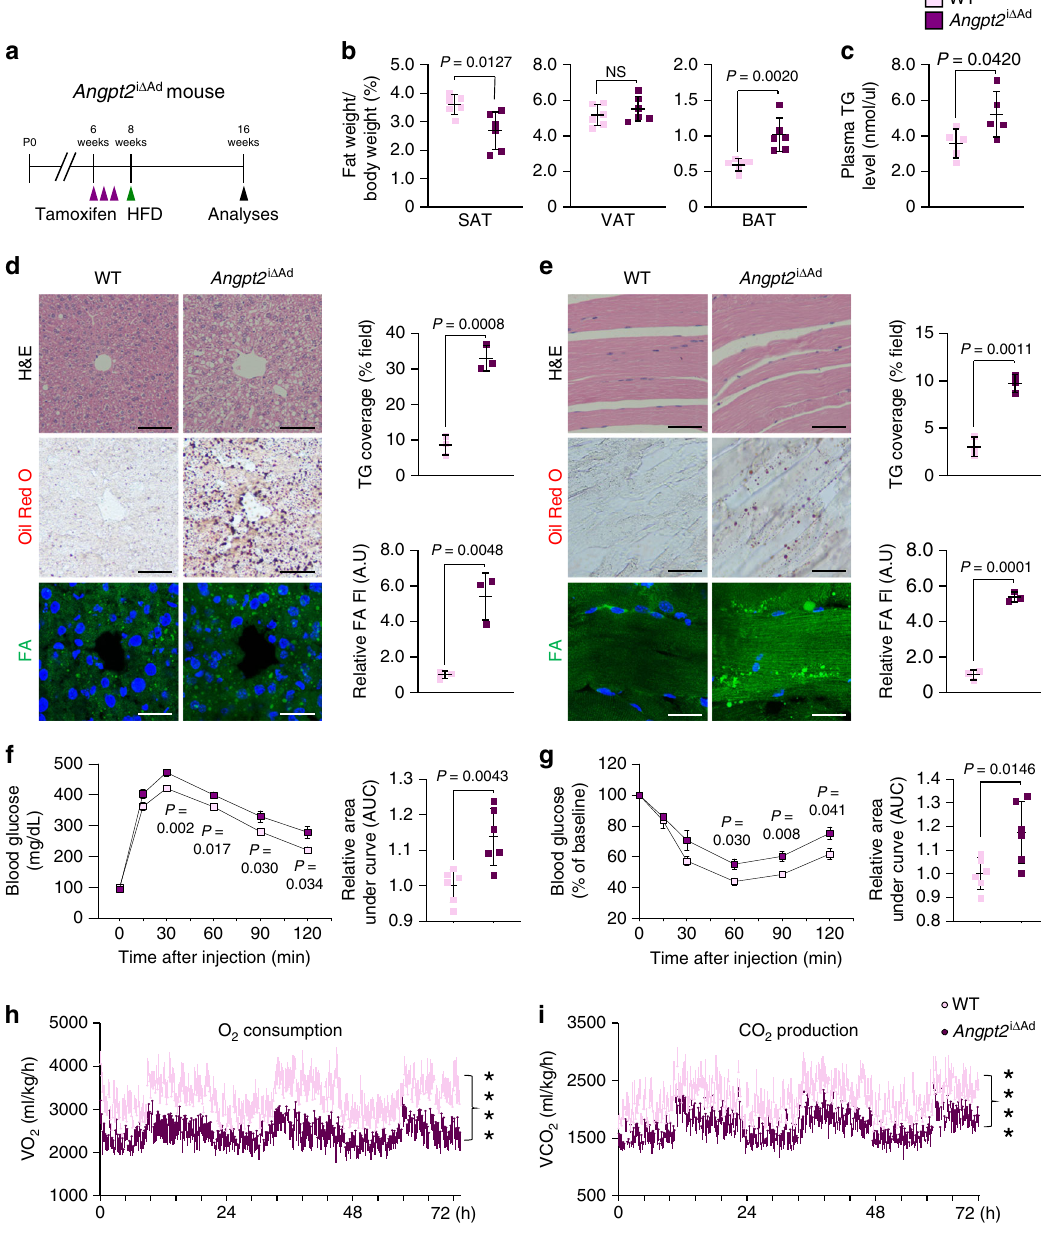
Fig. 9 Adipocyte-derived Angpt2 prevents ectopic lipid-induced insulin resistance. a Generation of Angpt2 i Δ Ad mouse, inducible and speci fi c deletion of Angpt2 in adipocytes in 6-week-old mice, and analysis after 8 weeks of HFD. Purple arrowheads indicate daily injections of tamoxifen. b Comparisons of fat-to-body weight ratio in different adipose tissues between WT and Angpt2 i Δ Ad mice fed with HFD. Each dot indicates a value obtained from one mouse and n = 6 mice/group pooled from two independent experiments. c Comparison of plasma triglyceride (TG) levels between WT and Angpt2 i Δ Ad mice. Each dot indicates a value obtained from one mouse and n = 5 mice/group pooled from two independent experiments. d Representative images and comparisons of H&E-stained sections, Oil Red O staining and coverage (% of fi eld), and BODIPY-FA staining and uptake ( fl uorescent unit, FI) of liver between WT and Angpt2 i Δ Ad mice fed with HFD. Each dot indicates a mean of triplicate values from three independent experiments. Scale bars, 50 μ m. e Representative images and comparisons of H&E-stained sections, Oil Red O staining and coverage (% of fi eld), and BODIPY-FA staining and uptake (FI) of skeletal muscle between WT and Angpt2 i Δ Ad mice fed with HFD. Each dot indicates a mean of triplicate values from three independent experiments. Scale bars, 50 μ m. f , g Comparisons of intraperitoneal glucose tolerance test (IPGTT) and intraperitoneal insulin tolerance test (IPITT) with corresponding area under curve (AUC) between WT and Angpt2 i Δ Ad mice fed with HFD. Each dot indicates a value obtained from one mouse and n = 6 mice/group pooled from three independent experiments. Horizontal bars indicate mean ± SEM. * P < 0.05; *** P < 0.001 versus WT by two-tailed Student ’ s t test. h , i Comparisons of O 2 consumption and CO 2 production. HFD fed WT and Angpt2 Δ Ad mice were subjected to metabolic cage assessment with CLAMS analysis. Each group, n = 6. Horizontal bars indicate mean ± SEM. **** P < 0.0001 versus WT by two-tailed Student ’ s t test. Unless otherwise denoted, horizontal bars indicate mean ± SD and P values versus WT by two-tailed Student ’ s t test ( c , e , f , g ). NS not signi fi